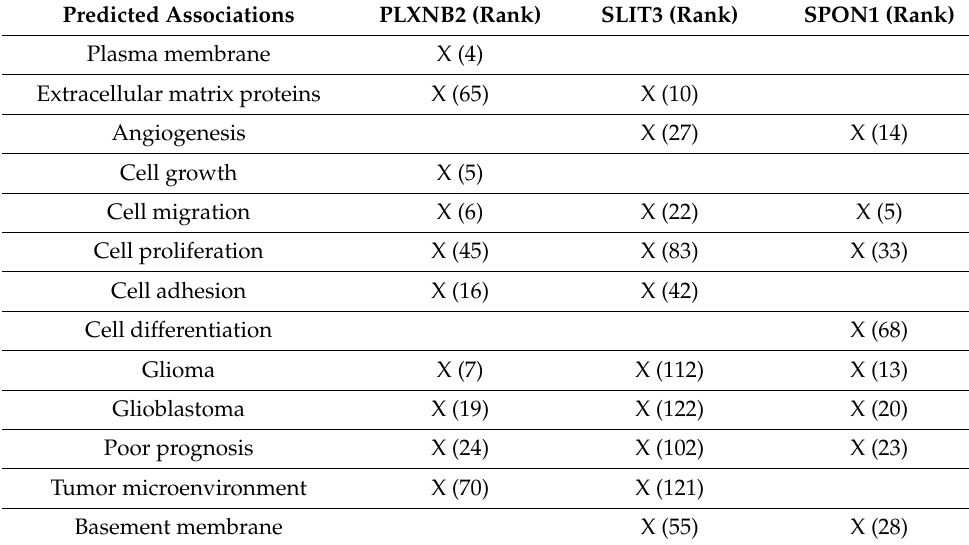
Table 1. Summary of some common and uncommon GAMMA-predicted associations for PLXNB2, SLIT3, and